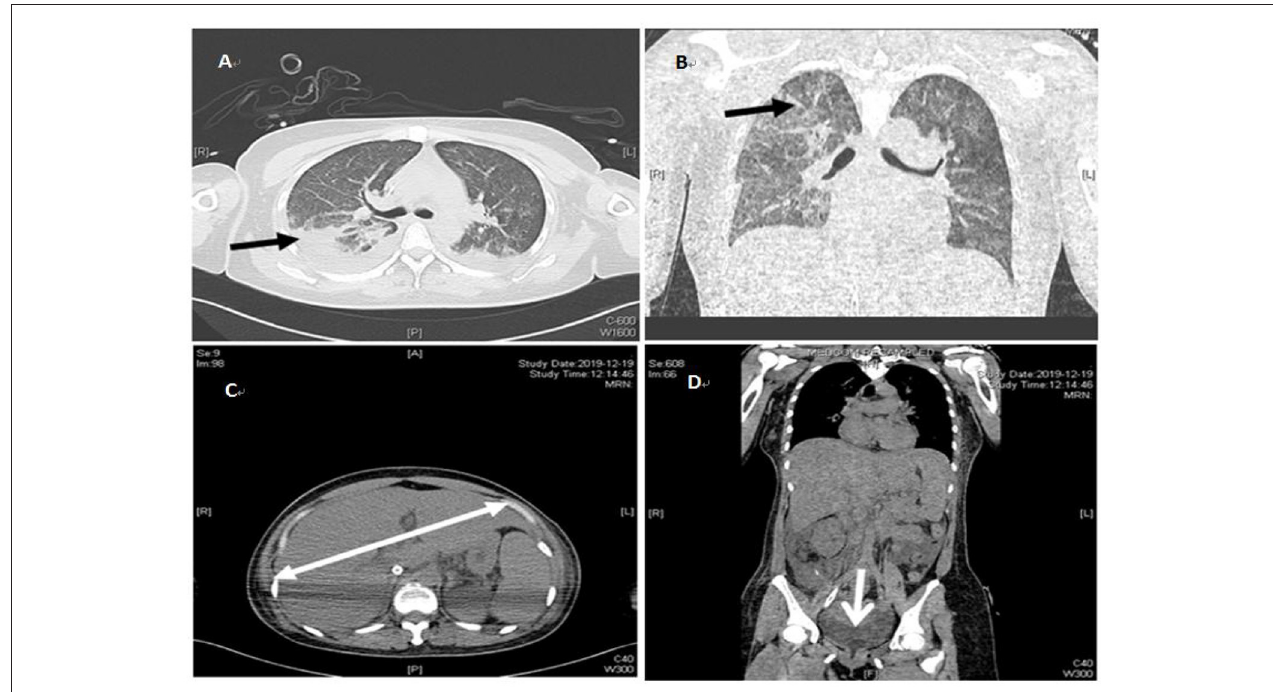
FIGURE 2 | Repeat chest and abdominal CT on December 19, 2019. (A) indicates pleural effusion (black arrows). (B) indicates patchy blurring (black arrows). (C) indicates the enlarged liver (white k arrows). (D) indicates pelvic effusion (white k arrows).